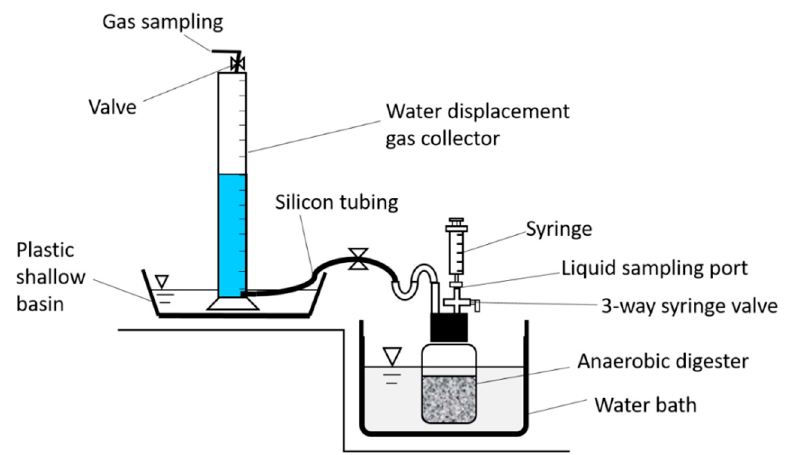
Figure 1. Sketch of the digester design.